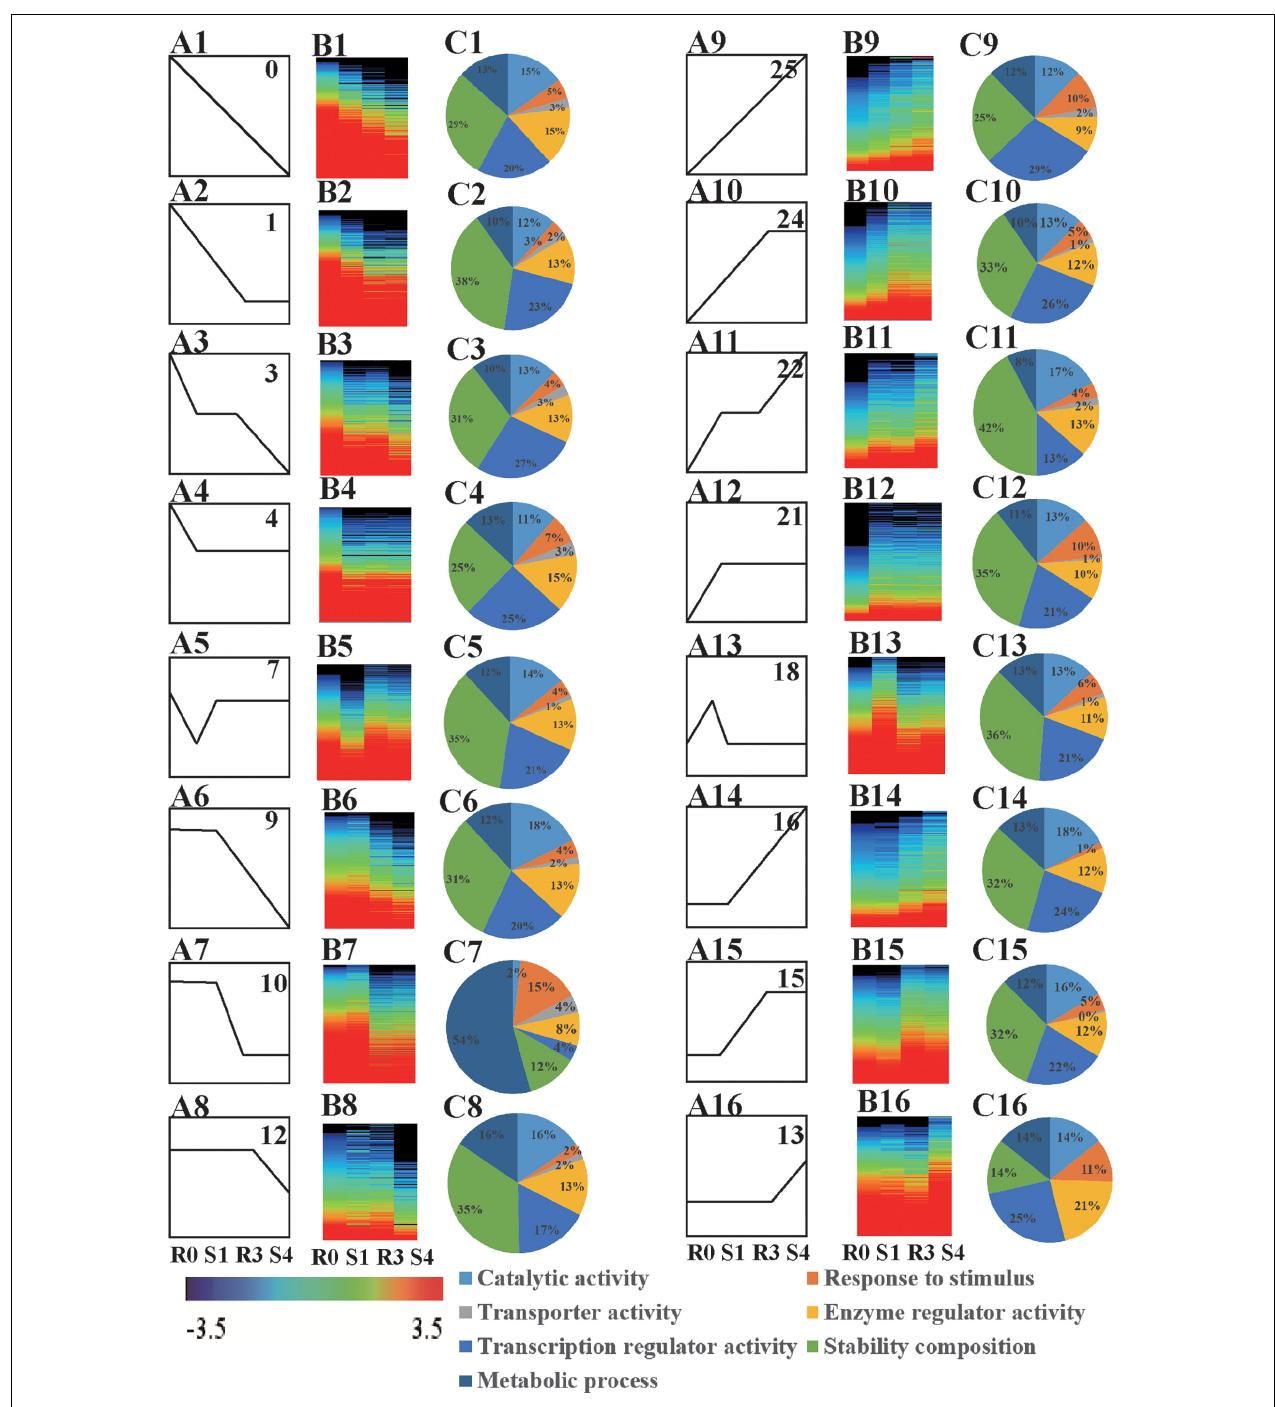
FIGURE 2 | Analysis of memory genes. (A) Expression profiles of drought memory genes (A1–A16) . (B) Heatmap of expression profiles indicated in (A) (B1–B16) . (C) GO biological processes, cellular components, and molecular functions enriched (FDR < 0.05) among drought memory genes indicated in (A) (C1–C16)